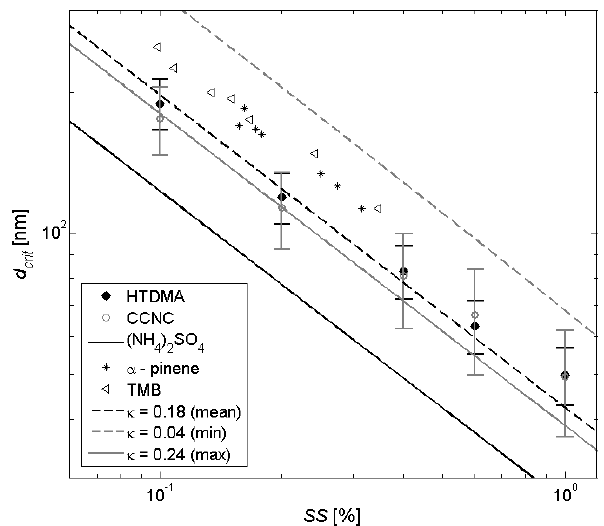
Fig. 5. Average critical diameter estimated from CCNC and HT- DMA data as a function of water supersaturation. Error bars show the standard deviations over the one-year data set. Data from lab- oratory measurements by Duplissy et al. (2008) with α -pinene and trimethylbenzene (TMB) aerosol are plotted with markers (stars and triangles). Lines show theoretical values for pure ammonium sul- phate particles (black solid line), and three different κ values. The κ =0.18 was determined in this study, and κ =0.04 and 0.24 span the range of κ values presented in the literature for organic (monoter- pene) aerosol (Engelhart et al.,